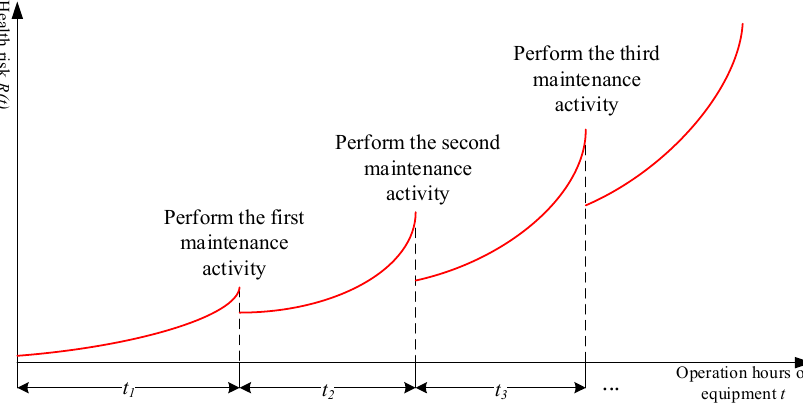
Figure 5. Chart of health risk change trend under maintenance activities.